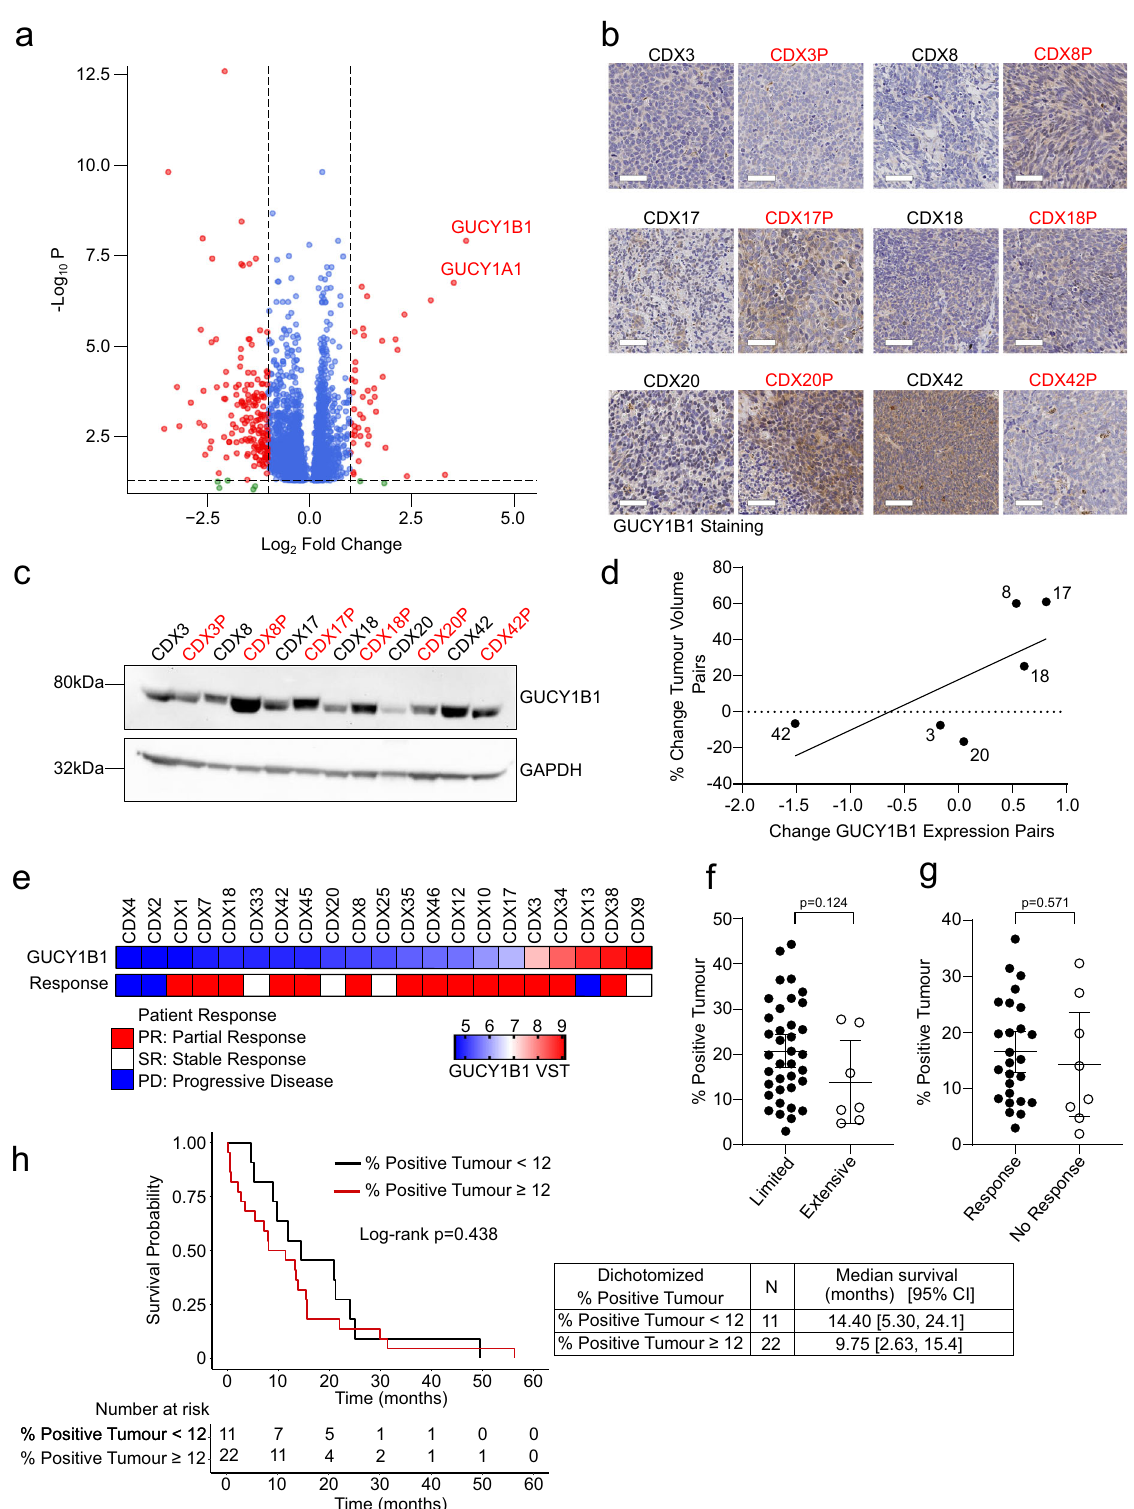
signalling, shown by an increase in HES1 ( p < 0.001) and GUCY1B1 ( p = 0.005) expression (Fig. 3f). We sought to con fi rm and extend these results obtained from established cell lines in CDX ex vivo cultures, generated by disaggregation of CDX tumours, and short- term culture of derived human cells 15 . Endogenous Notch pathway signalling promotes an NE to Non-NE fate switch in a SCLC GEMM 12 . CDX17 and CDX17P ex vivo cultures of NE and Non-